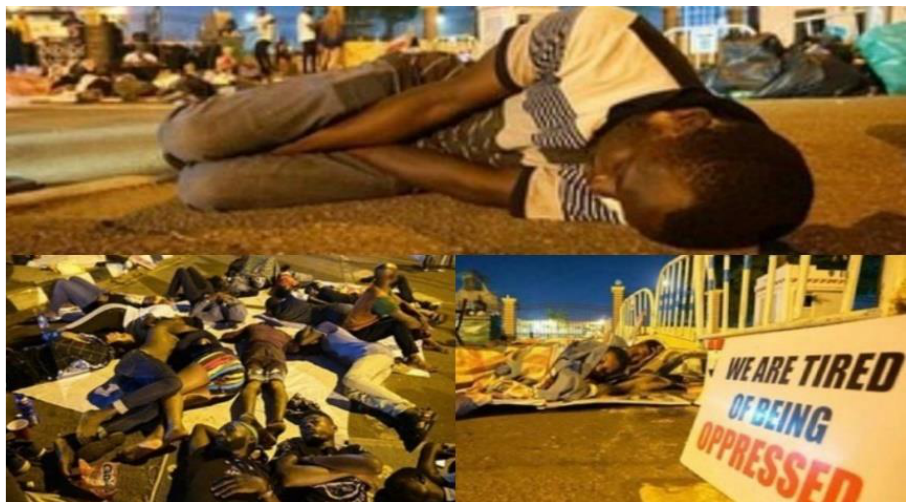
Figure 5: #EndSARS protesters asleep at the Lekki tollgate; Source: Natty, 2020.